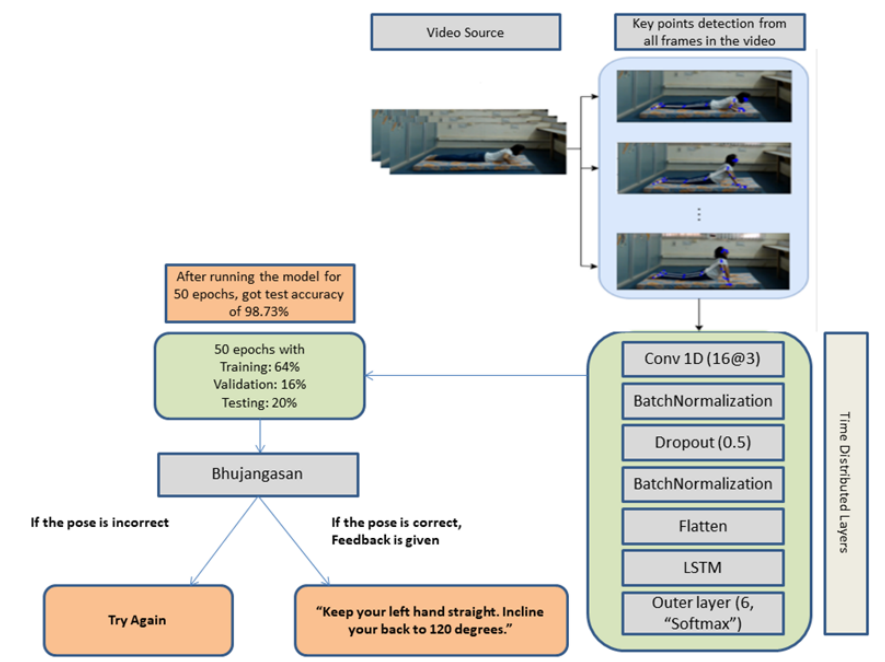
Figure 1. Flowchart of Proposed